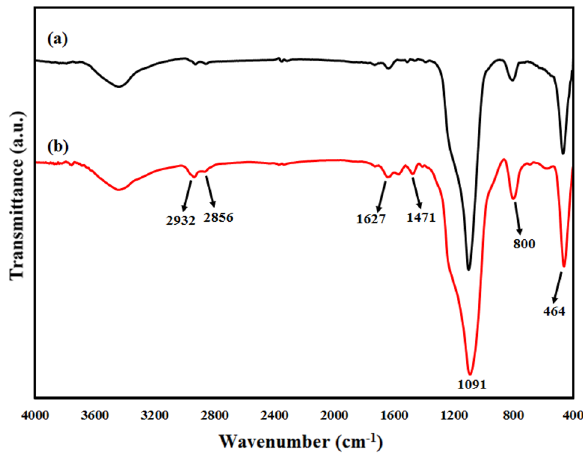
Figure 3. FTIR spectra of ( a ) KCC-1 and ( b ) KCC-1-NH 2 samples.